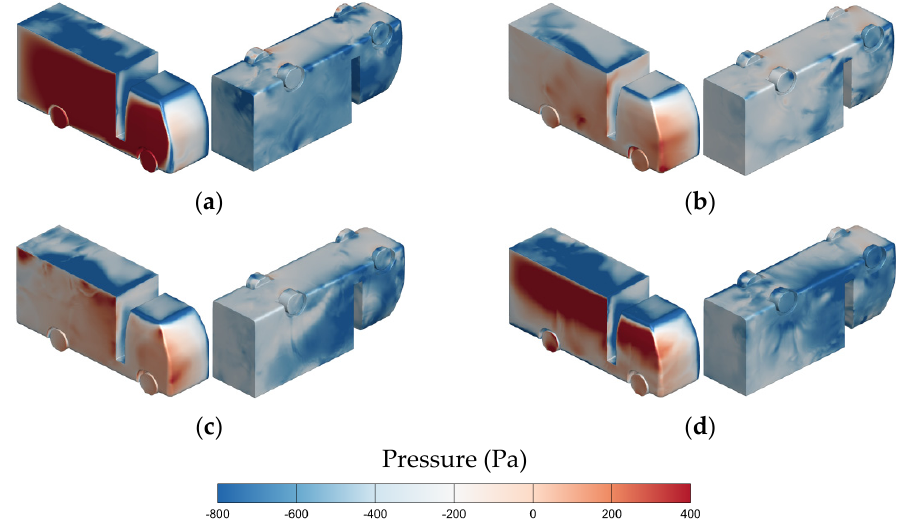
Figure 9. Pressure distribution for different porosity schemes (( a ) Bare bridge; ( b ) Scheme 1; ( c ) Scheme 2-1; ( d ) Scheme 3).